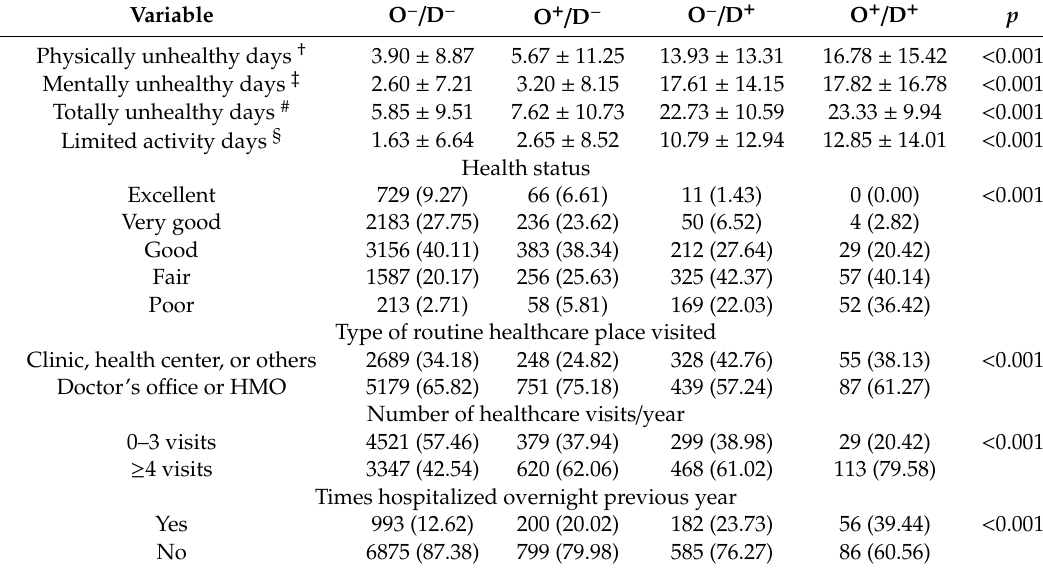
Figure 1. Flow chart of this study. Table 2. The distributions of HRQoL and hospital use between disease